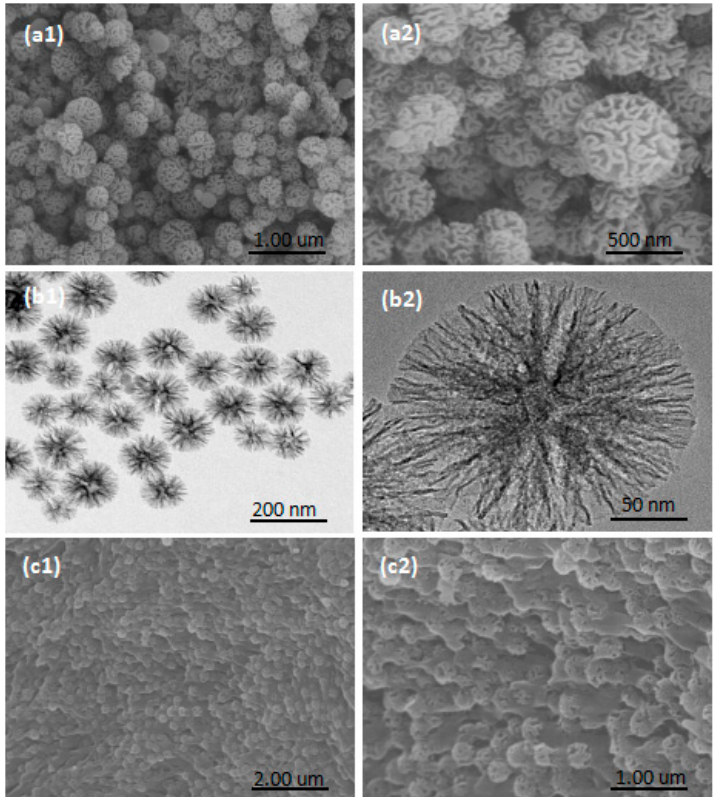
Figure 1. Scanning electron microscopy (SEM) ( a ) and transmission electron microscopy (TEM) ( b ) images of nanoflower-like wrinkled mesoporous silica (NFMS); SEM images ( c ) of Polyethylene glycol immobilized in NFMS (PEG/NFMS).